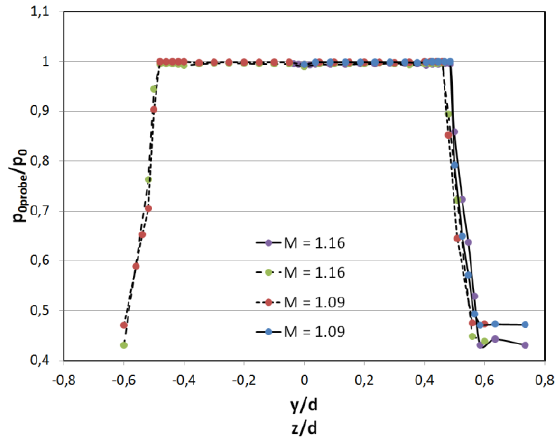
Fig. 10. Distribution of P 0p /Po across the flow at transonic nozzle outlet. x/d e =